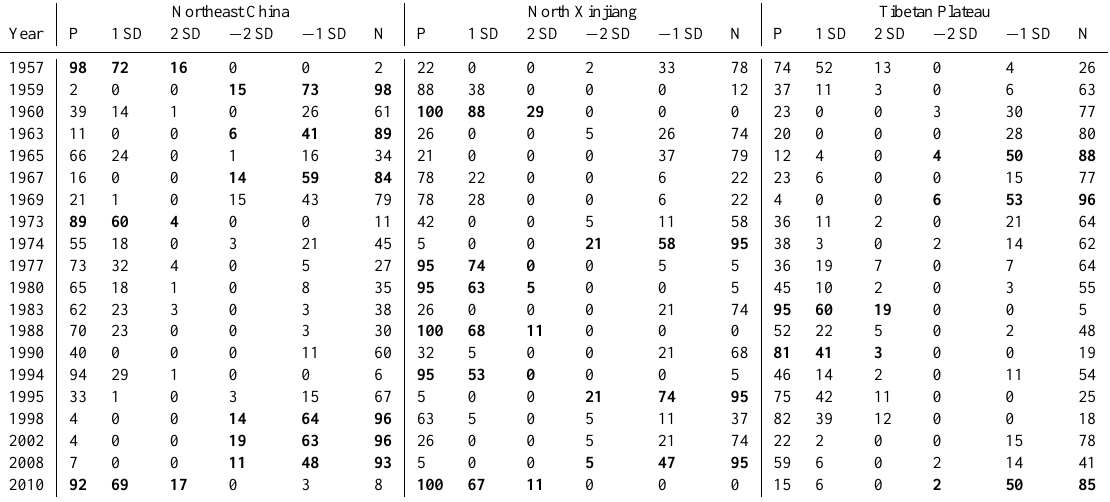
Table 3. The same as Table 2, but only for the years with a positive (negative) anomaly of SCDs and only for the three major stable snow regions: Northeast China (78 stations), north Xinjiang (21 stations), and the Tibetan Plateau (63 stations). Northeast China North Xinjiang Tibetan Plateau Year